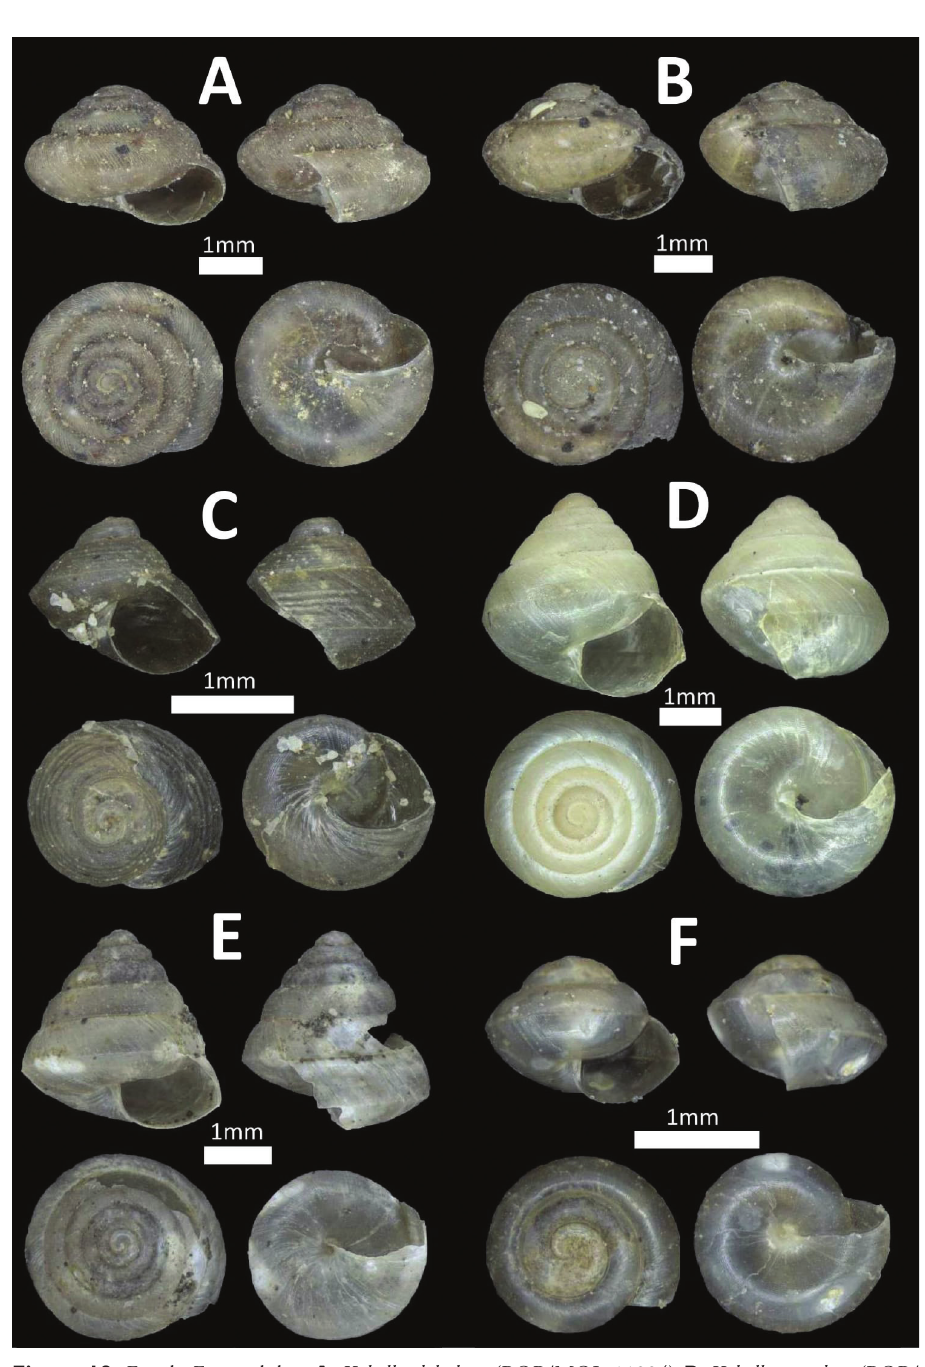
Figure 18. Family Euconulidae. A Kaliella doliolum (BOR/MOL 11994) B Kaliella scandens (BOR/ MOL 6688) C Kaliella dendrophila (BOR/MOL 11971) *Juvenile D Kaliella calculosa (BOR/MOL 10989) E Kaliella microconus (BOR/MOL 12202) F Kaliella barrakporensis (BOR/MOL 12461)